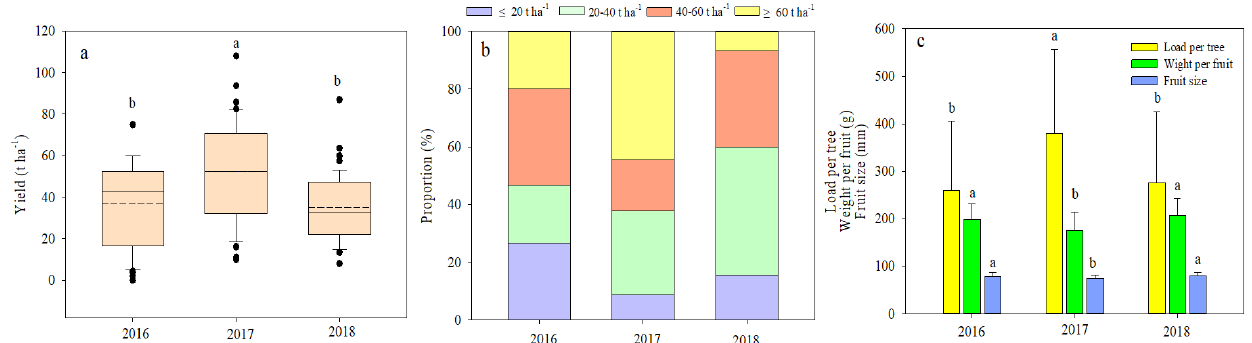
Figure 1. Actual apple yields and bearing features of orchards (n = 45) in 2016–2018 for Beiquan Village, Hebei, China. ( a ) Variations in the yield of farmers over three years. Box boundaries indicate upper and lower quartiles. The whisker caps indicate 90th and 10th percentiles, and the points indicate outliers. ( b ) The proportions of sampled orchards with a yield ≤ 20 t ha − 1 , 20–40 t ha − 1 , 40–60 t ha − 1 , and ≥ 60 t ha − 1 in 2016–2018. Light purple indicates the actual yield was ≤ 20 t ha − 1 , light green indicates the actual yield was 20–40 t ha − 1 , orange indicates the actual yield was 40–60 t ha − 1 , and yellow indicates the actual yield was ≥ 60 t ha − 1 . ( c ) Bearing features of sample orchards in 2016–2018. Yellow indicates the load per tree, green indicates the single fruit weight, and blue indicates the size of the fruit.